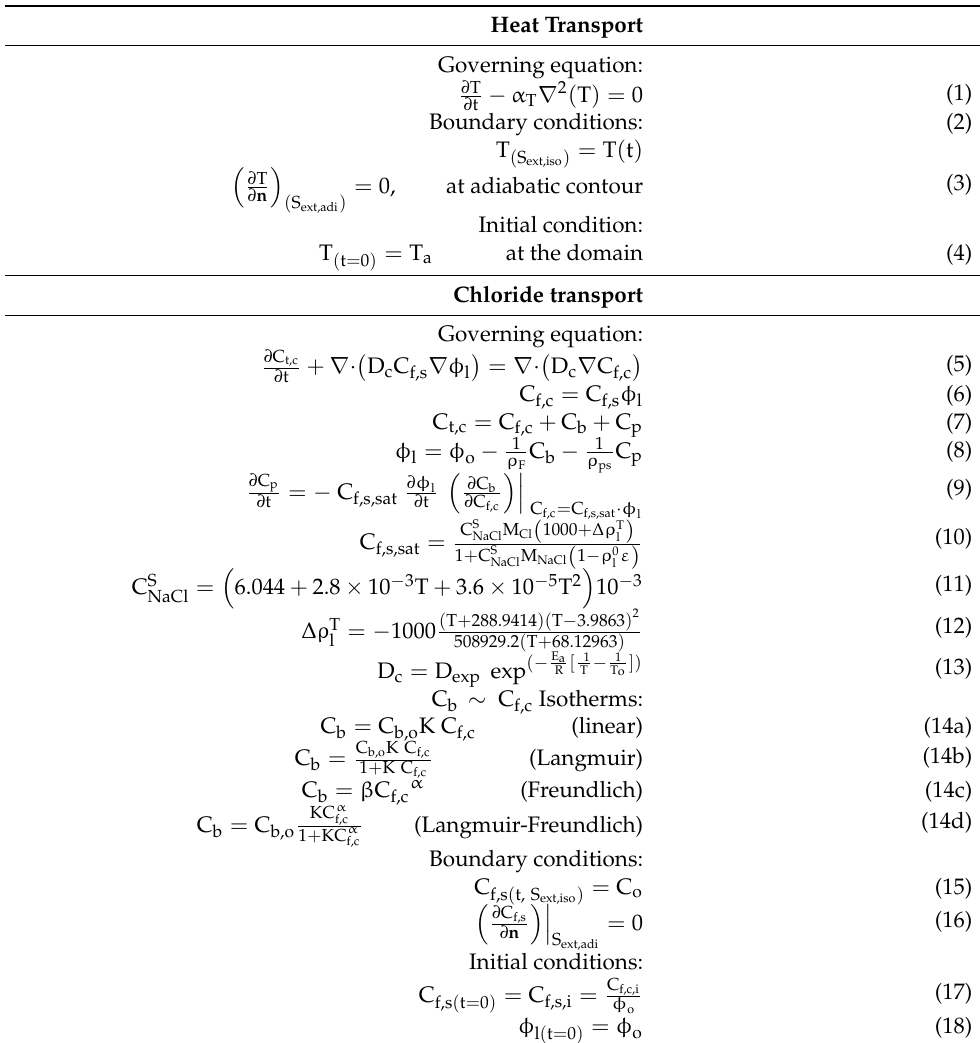
Table 1. Mathematical model of transport in saturated